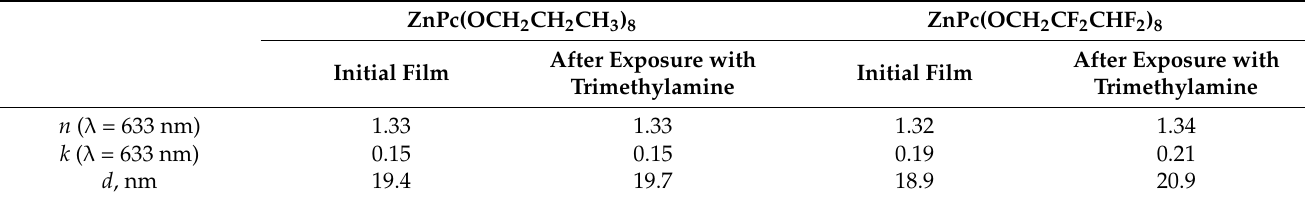
Figure 15. ( a ) Ψ ( λ ) and ∆ ( λ ) TIRE spectra: ( a ) ZnPc(OCH 2 CH 2 CH 3 ) 8 in air (curve 1); after injection of trimethylamine 200, 250 and 300 ppm (curves 2, 3 and 4, respectively); after flushing with air (curve 5); ( b ) the film of ZnPc(OCH 2 CF 2 CHF 2 ) 8 in air (curve 1); after injection of trimethylamine 20, 60, 100, 250 and 300 ppm (curves 2–6, respectively); after flushing with air (curve 7). Enlarged sections of ∆ ( λ ) spectra are shown on the top. Reprinted from [56] with permission from Elsevier. Table 4. Thickness (d), refractive indexes (n) and extinction coefficients (k) for ZnPc(OCH 2 CH 2 CH 3 ) 8 and ZnPc(OCH 2 CF 2 CHF 2 ) 8 films, before and after interaction with trimethylamine